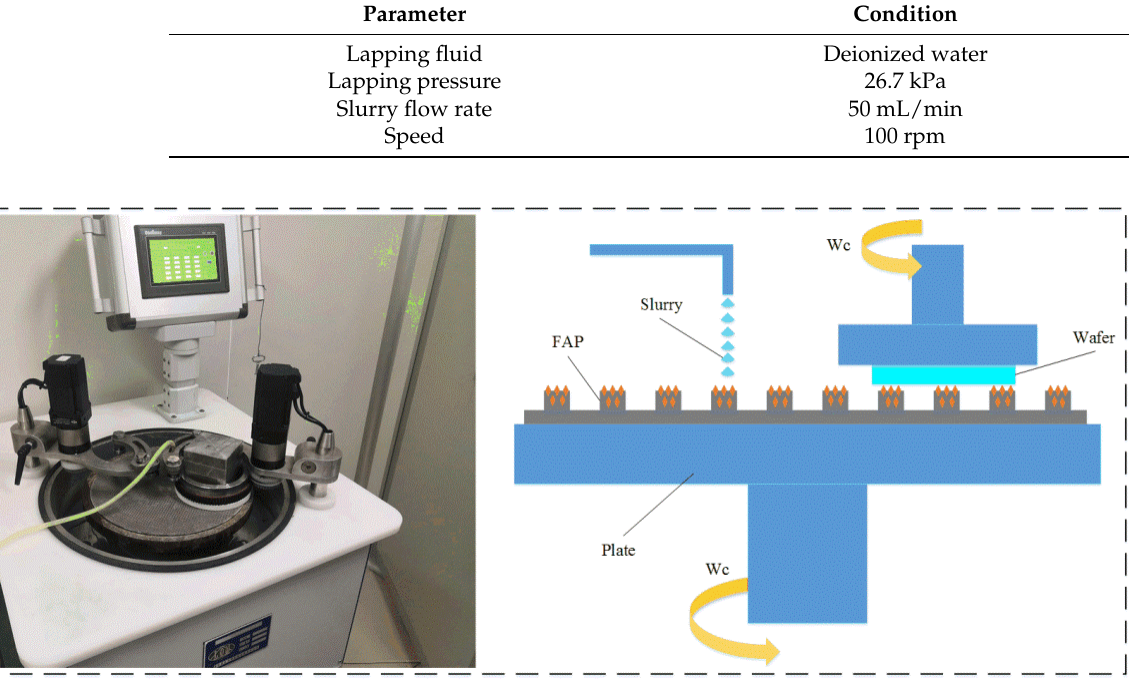
Figure 2. Ultra-precision plane lapping and polishing machine and its processing principle.